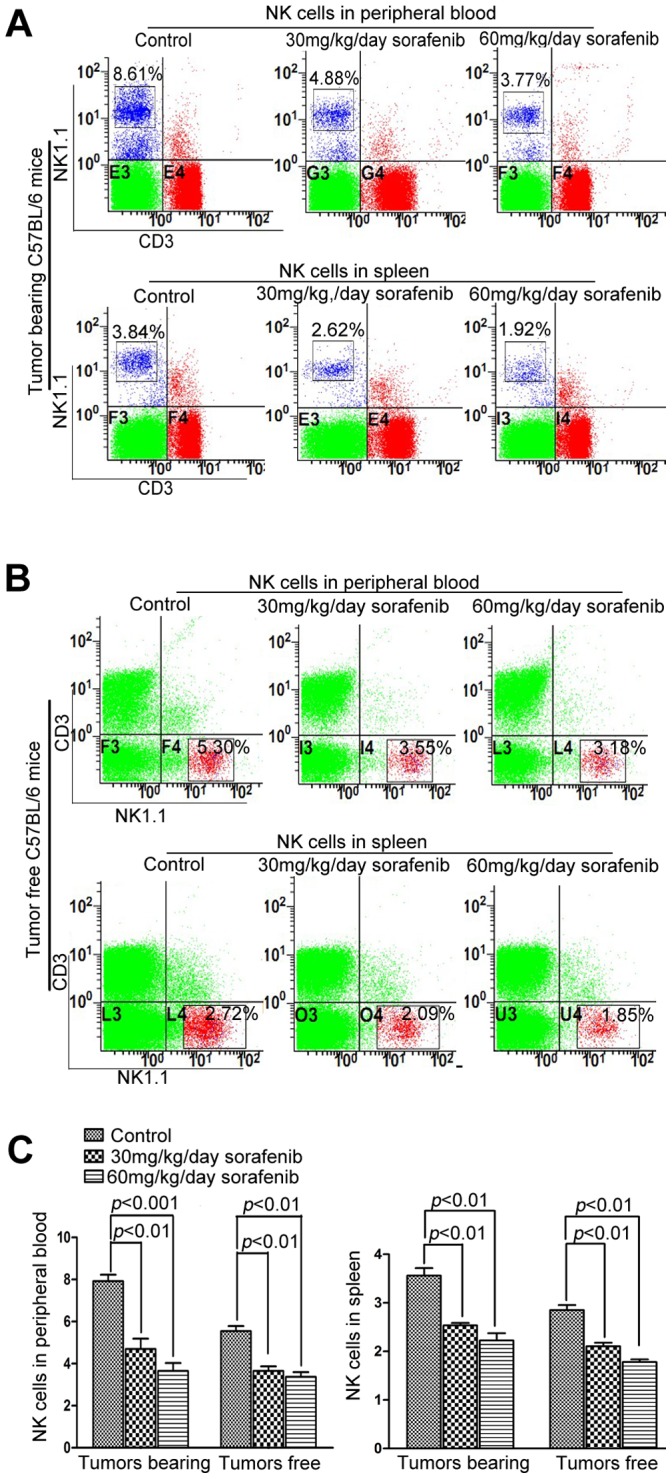
Sorafenib reduced the ratio of NK cells dose-dependently, in both tumor-free and tumor-bearing C57BL/6 mice.Sorafenib treatment was started one week after tumor implantation and continued for two weeks. Then, NK cells were harvested for further measurement. (A, C) The ratio of NK cells was 7.92±0.61% in the controls and 4.70±0.98%, and 3.66±0.74% in the 30 mg·kg−1·day−1 sorafenib and 60 mg·kg−1·day−1 sorafenib groups (n = 5 for each group), respectively (p<0.001). For tumor-bearing mice, the ratio was 3.56±0.31% in controls and 2.54±0.99% and 2.23±0.30% in the 30 mg·kg−1·day−1 sorafenib and 60 mg·kg−1·day−1 sorafenib groups, respectively (p<0.01). (B, C) Sorafenib also reduced the ratio of NK cells dose-dependently in the peripheral blood and spleens of tumor-free mice (n = 5 for each group): 2.85±0.21% in controls and 2.11±0.15% and 1.78±0.11% in the 30 mg·kg−1·day−1 and 60 mg·kg−1·day−1 groups, respectively, in the spleens (p<0.001, right panel); and 5.54±0.49% in the controls and 3.66±0.43% and 3.37±0.45% in the 30 mg·kg−1·day−1 and 60 mg·kg−1·day−1 groups, respectively, in peripheral blood.